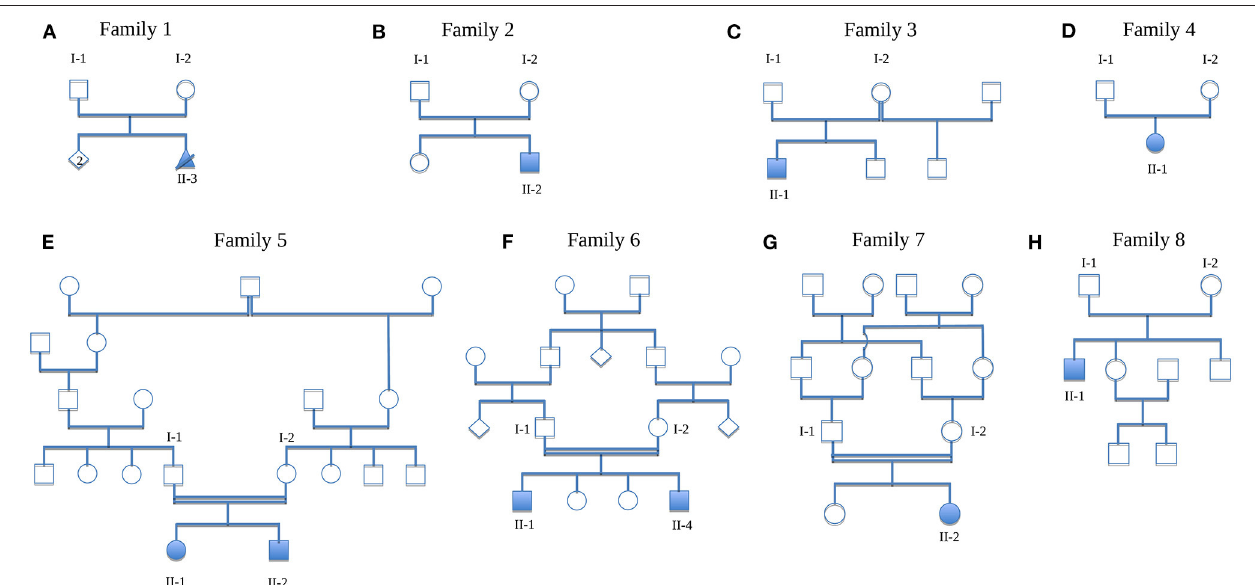
FIGURE 1 | Pedigrees of the families. (A) Family 1 (HN-F18), (B) Family 2 (HN-F151), (C) Family 3 (HN-F75), (D) Family 4 (HN-F80), (E) Family 5 (HN-F191), (F) Family 6 (HN-F198), (G) Family 7 (HN-F241), (H) Family 8 (HN-F305). Solid symbols, affected individuals; circles, females; squares, males; crossed triangle, miscarriage; diamond, unknown gender; double lines,